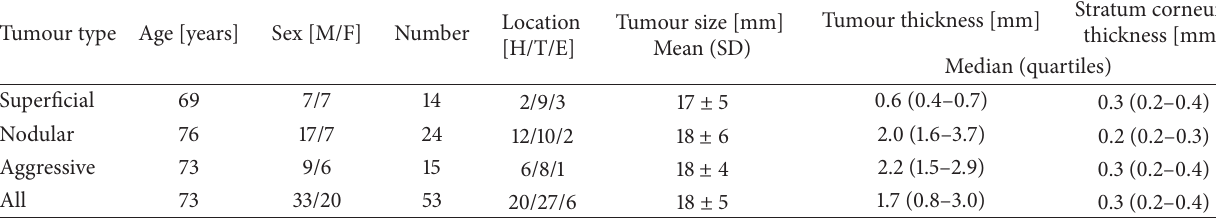
Table 1: Descriptive data of patients and BCCs.